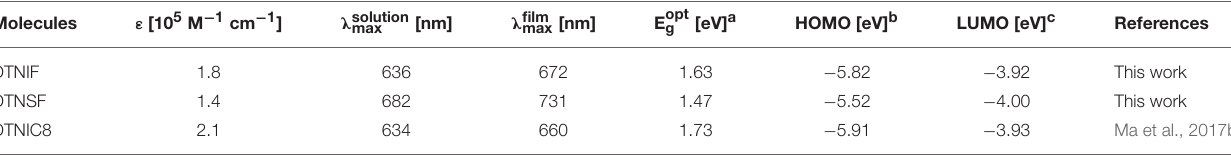
TABLE 1 | Optical and electrochemical properties of DTNIF and DTNSF. Molecules